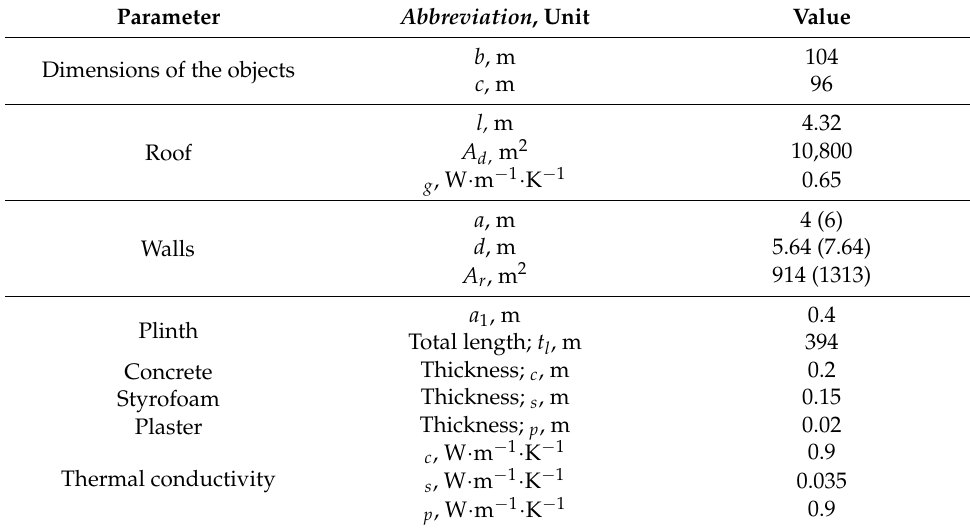
Table 2. Characteristic parameters of the analysed